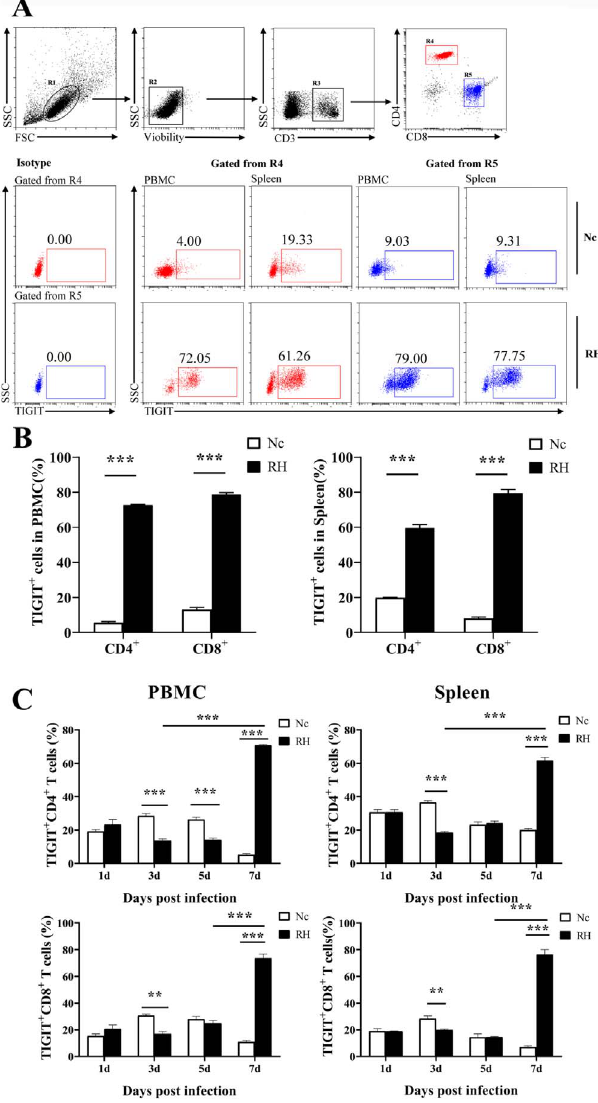
Figure 1. Changes in TIGIT expression on T cells in different tissues after T. gondii infection. (A) Proportions of TIGIT + cells among CD4 + and CD8 + T cells in T. gondii- infected (RH) and normal mice (Nc) at 7 days after infection. (B) Results of statistical analysis of the percentage of TIGIT + cells among CD4 + T and CD8 + T cells in RH and Nc mice at 7 days after infection. (C) Dynamic changes in the percentages of TIGIT + in T cells at different time points. The results are representative of three independent experiments with fi ve mice in each group per experiment, with data denoting means ± SDs.